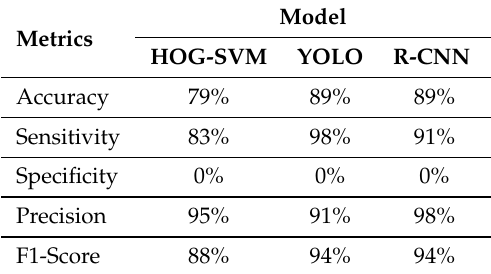
Table 1. The performance evaluation of ML models in testing phase.